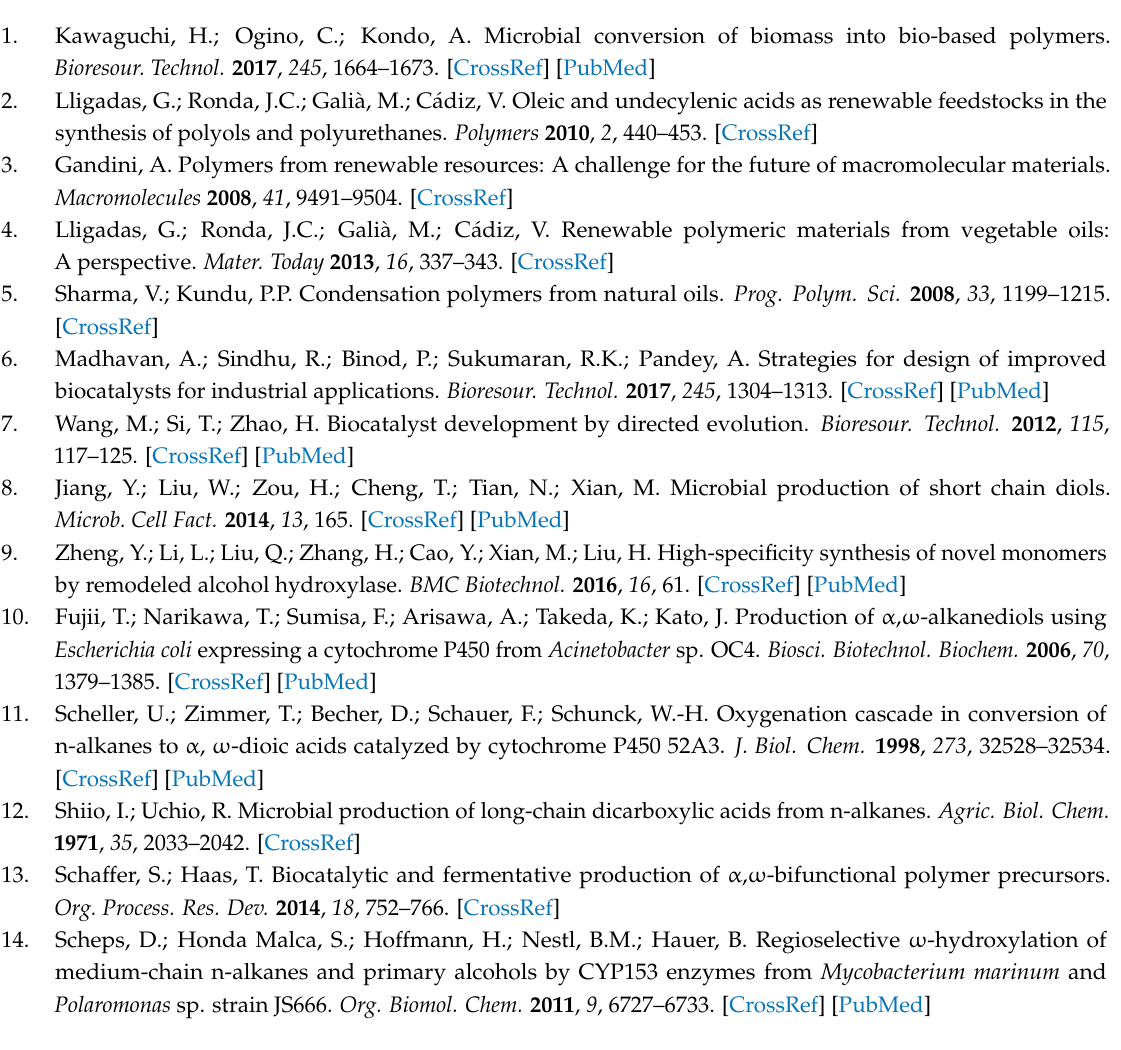
Figure S4, Proposed reaction scheme for the biosynthesis of benzyl alcohol and fatty alcohols (C 8 –C 16 ); Figure S5, In vivo production of fatty alcohol using E. coli BW25113 ( ∆ fadD, DE3) cells expressing MmCAR, and Sfp; Figure S6, Production of alcohols by E. coli endogenous ALRs using E. coli BW25113 ( ∆ fadD, DE3); Figure S7, Effect of pH for the optimum activity of CAR using E. coli BW25113 ( ∆ fadD, DE3) cells expressing MmCAR, Sfp, and endogenous ALRs; Figure S8, (A) SDS PAGE analysis of recombinant E. coli expressing MaqCYP153A33 (~55.2 kDa), CamA (~47.8 kDa), and CamB (~11.6 kDa). (B) CO binding spectrum of active MaqCYP153A33. Table S1, Retention time of the substrates and products by Gas